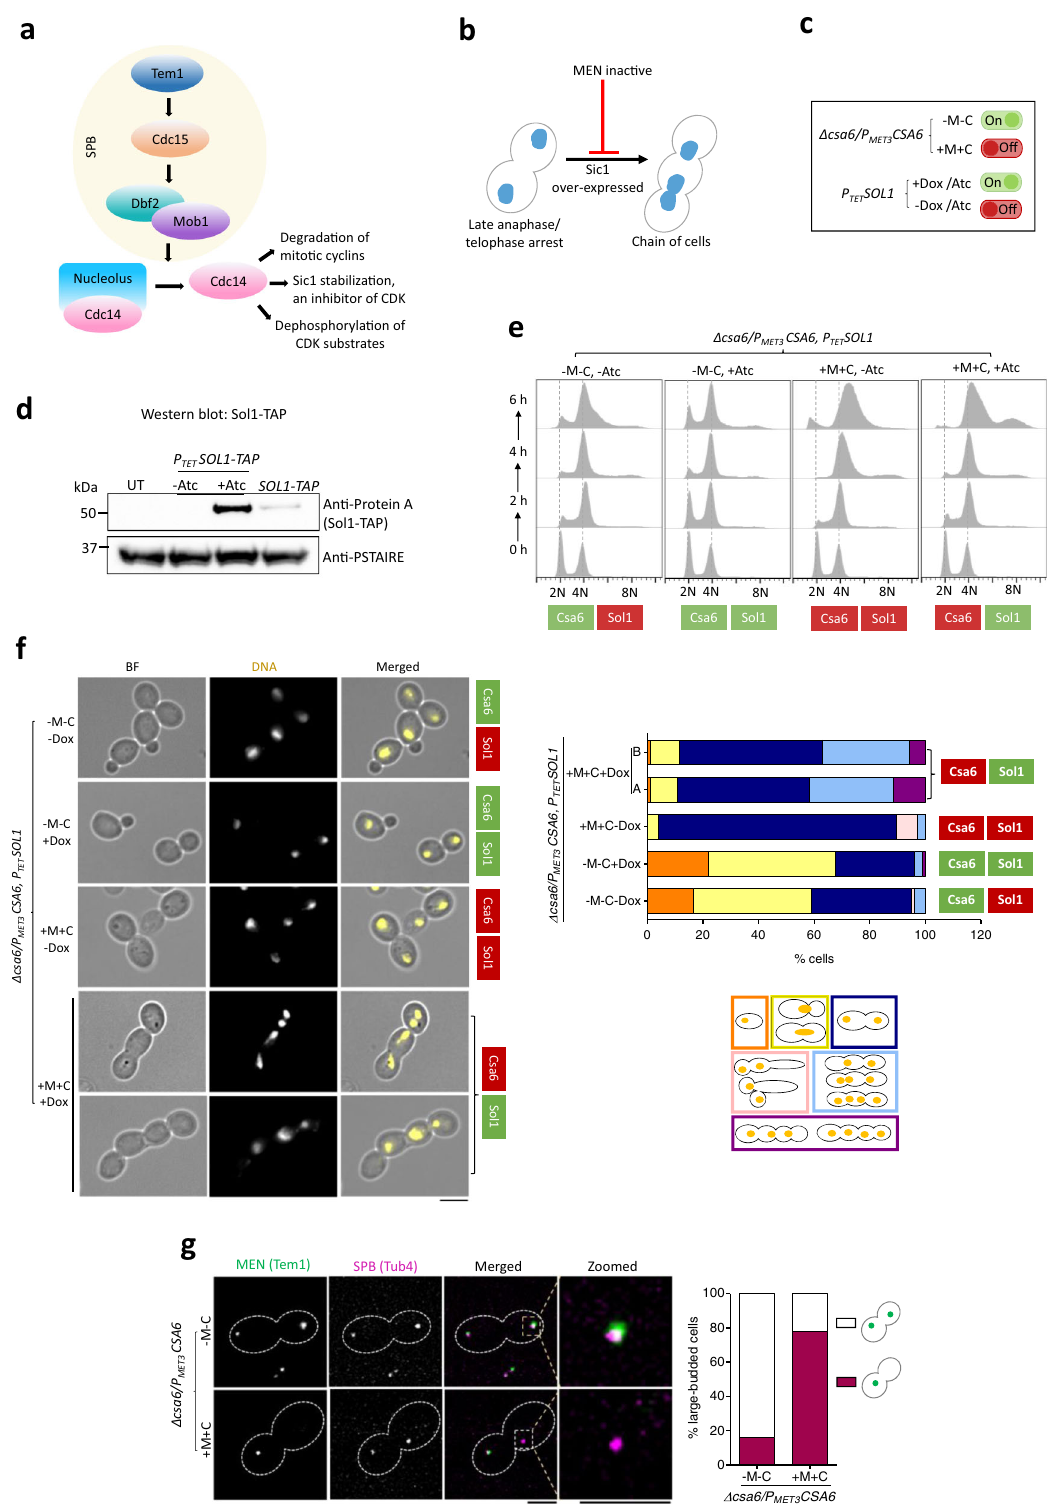
To further elucidate the function of Csa6 across CUG clades species, we ectopically expressed GFP-tagged Csa6 of two other Candida species, Candida tropicalis and Candida parapsilosis , in C. albicans . The putative Csa6 orthologs are poorly conserved in both C. tropicalis (CtCsa6) (Fig. 7d) and C. parapsilosis (CpCsa6) (Supplementary Fig. 12b). Incidentally, CtCsa6, but not CpCsa6, functionally complemented CaCsa6 functions in C. albicans